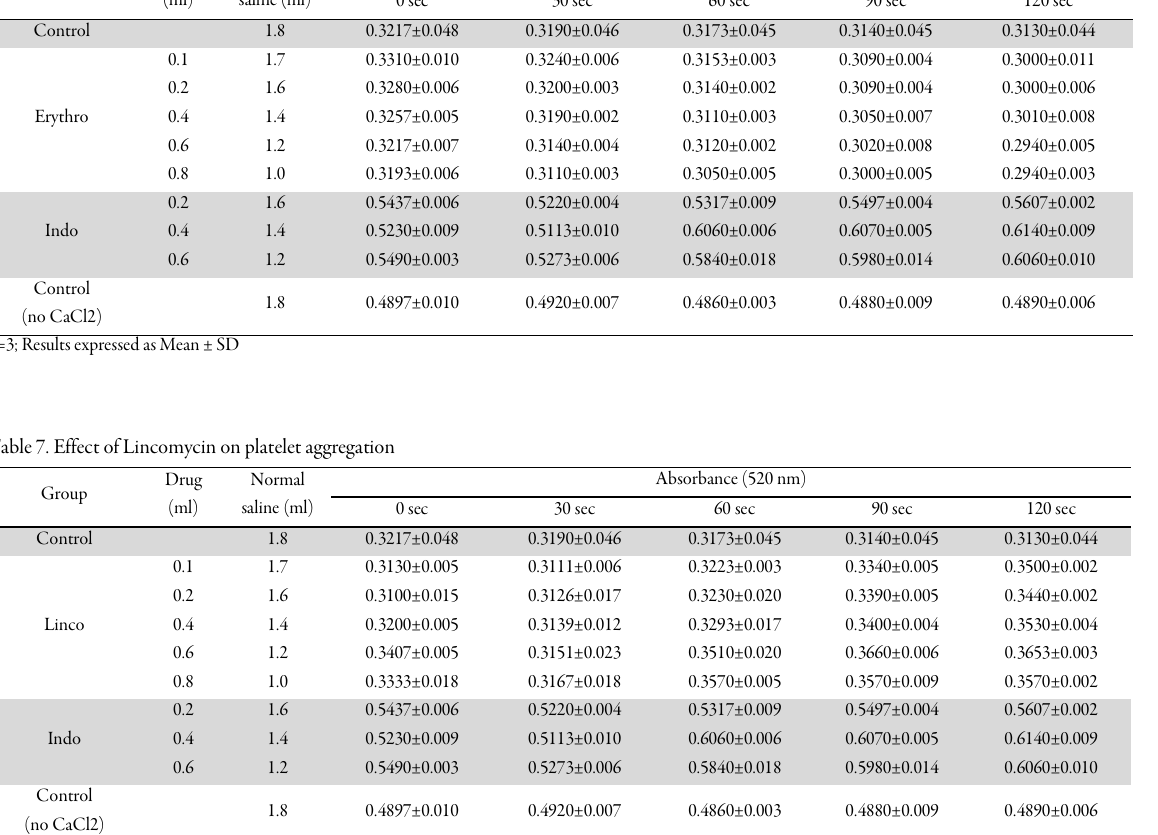
Table 6. Effect of Erythromycin on platelet aggregation Group